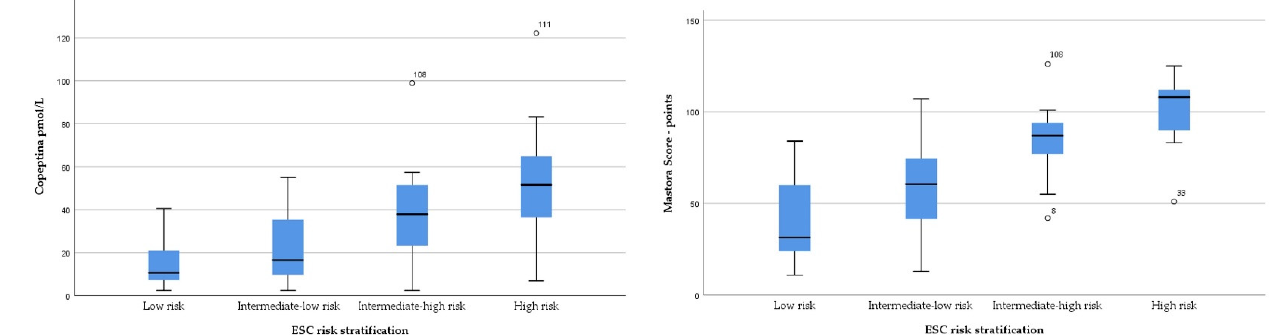
Figure 1. Copeptin and Mastora score distributions according to ESC risk stratification.